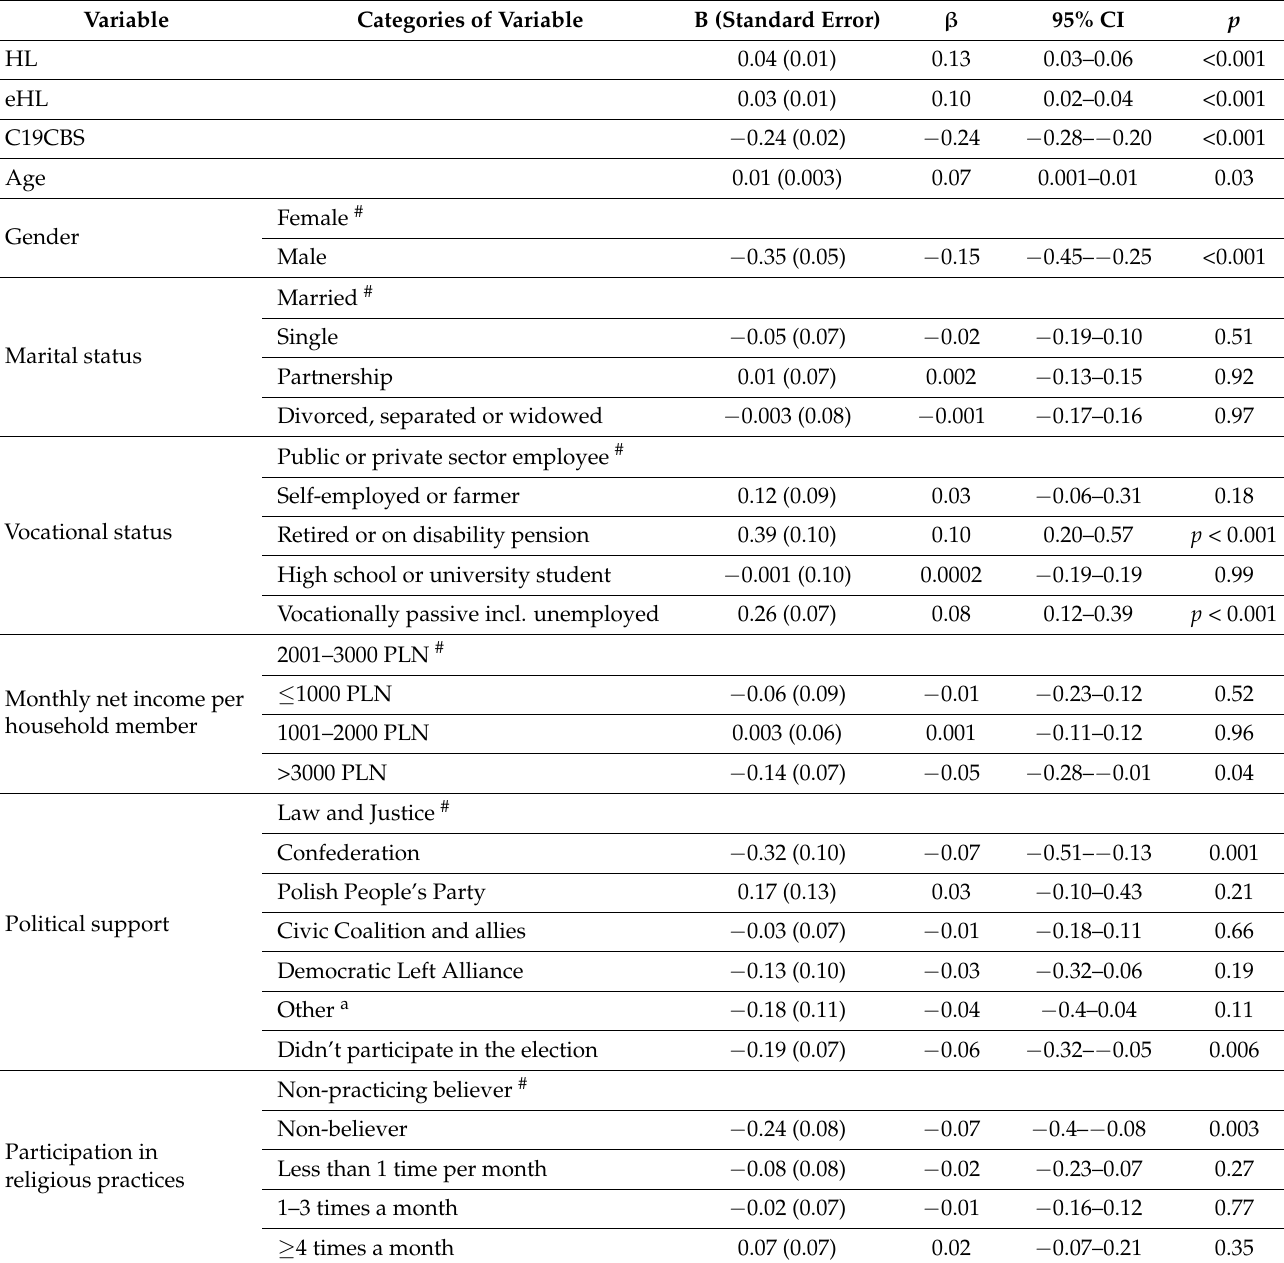
Table 5. Multivariable linear regression model of the preventive measures